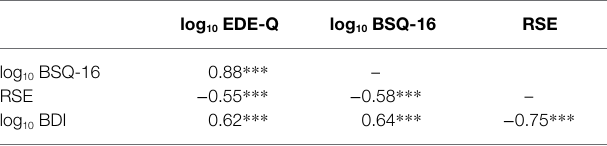
TABLE 3 | Pearson correlations between psychometric variables.